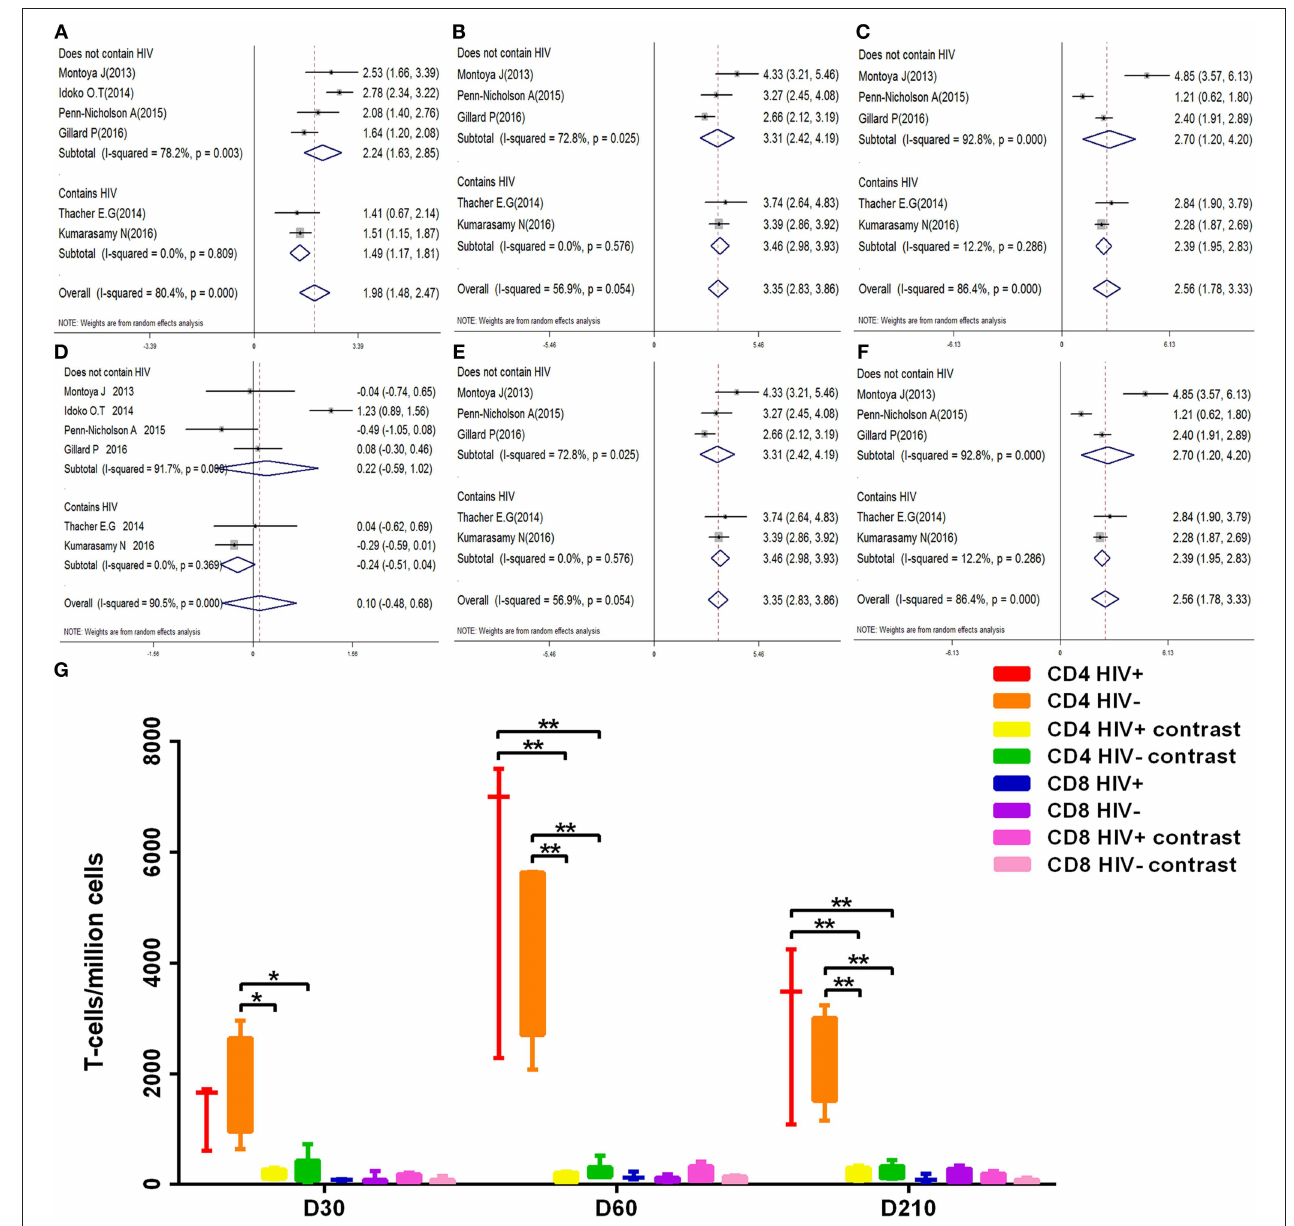
FIGURE 7 | Subgroup analysis polyfunctional CD4 + and CD8 + T-cell. (A–F) Forest plot: a SMD > 0 indicates that vaccine can effectively stimulate the growth of polyfunctional CD4 + or CD8 + T-cells. SMD = 0, invalid result. (A–C) are the result of polyfunctional CD4 + T-cell analysis of D30, D60, and D210, respectively. (D–F) are the result of polyfunctional CD4 + T-cell analysis of D30, D60, and D210, respectively. (G) Box diagram: The transverse coordinates are the date of vaccination. The longitudinal coordinates are the number of polyfunctional CD4 + or CD8 + T-cells. Statistically significant differences between the two groups are indicated by star symbols: * p < 0.05; ** p <